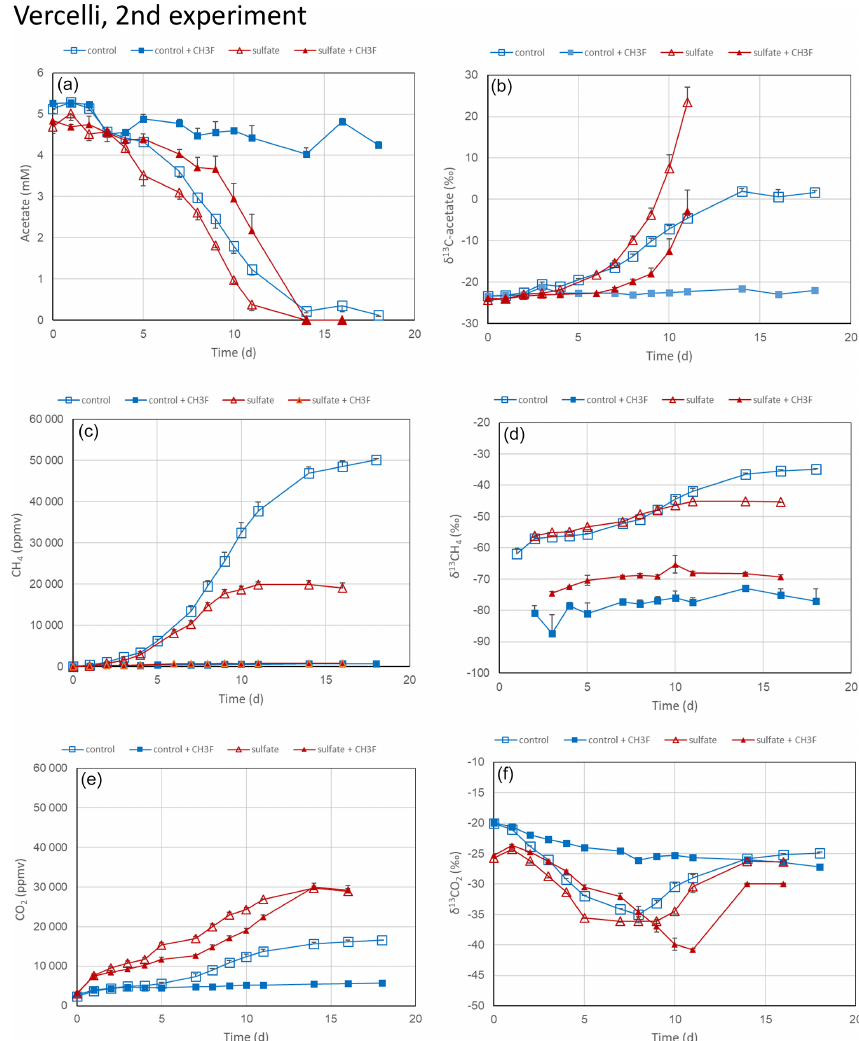
Figure 4. Acetate conversion to CH 4 and CO 2 in phosphate-buffered (pH 7.0) suspensions of paddy soil from Vercelli, Italy, without additions (control), with CH 3 F, with gypsum (preincubation and experiment), and with gypsum (preincubation and experiment) and CH 3 F. The panels show the temporal change of (a) concentrations of acetate, (b) δ 13 C of acetate, (c) partial pressures of CH 4 (1ppmv = 10 − 6 bar), (d) δ 13 C of CH 4 , (e) partial pressures of CO 2 (1ppmv = 10 − 6 bar) and (f) δ 13 C of CO 2 . Means ± SE, n =